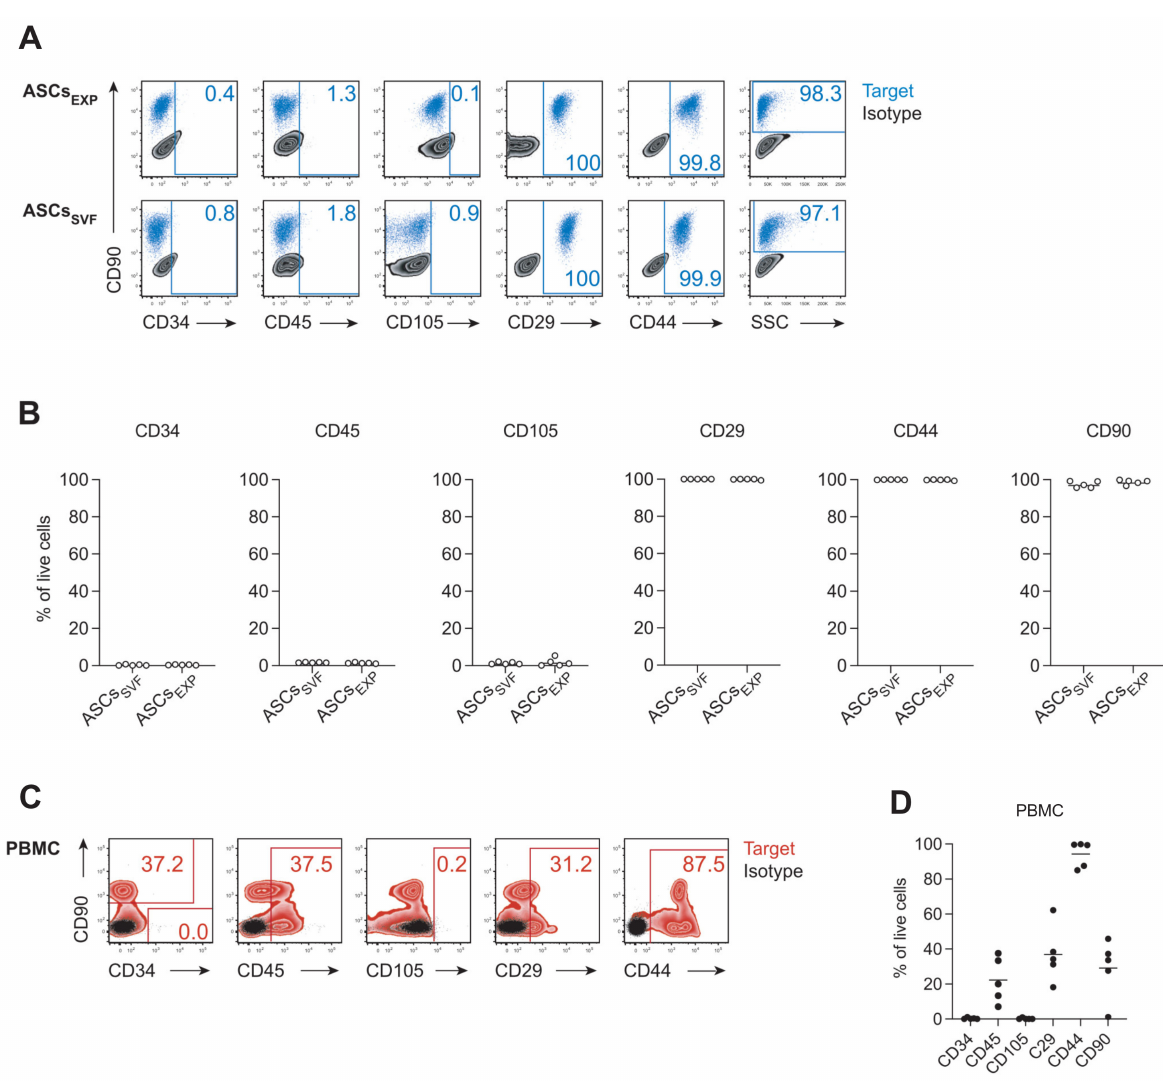
Figure 3. Characterization of equine abdominal adipose tissue-derived stem/stromal cells (ASCs) by flow cytometry. ( A ) Surface marker expression by ASCs- EXP and ASCs- SVF . Representative overlay plots including fully stained cells (target, blue) and isotype controls (black) are shown. ( B ) Marker expression by ASCs generated with the two protocols. Data pooled from two (ASCs- SVF ) and four (ASCs- EXP ) independent experiments, each performed with cells from one to three individual donors. ( C ) Equine peripheral blood mononuclear cells (PBMC, n = 5) were used as positive controls to survey the binding of the antibodies applied for the characterization of equine stem cells. Representative overlay plots report fluorescence signals detected with fully stained cells (target, red) and isotype controls (black). The CD90 was stained in all samples. Numbers indicate the percentage of cells expressing the target molecules. ( D ) Marker expression by PBMC isolated from five donors. Gating strategies are reported in Supplementary Figure S1. FSC, forward scatter; SSC, side